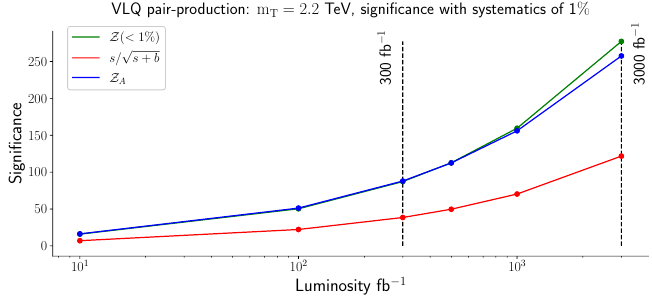
Figure 9. Statistical significance as a function of the integrated luminosity for the three statistical metrics under consideration. We fix the lightest VLQ mass as m T = 2 . 2 TeV . The green curve represents the Z ( < 1%) metric, the red curve indicates the s/ our results for the Asimov significance Z A